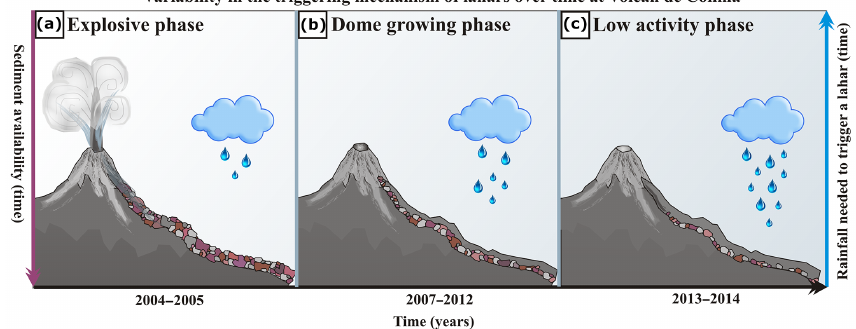
Figure 8. Conceptual model of the variability in the conditions needed to trigger a lahar over time at Volcán de Colima. (a) After the main explosive phase during 2004–2005, the slopes of the volcano were filled with material, and the rate of rainfall needed to trigger a lahar was minor. (b) During the dome growing phase (from 2007 to 2012), the amount of material decreased, while the amount of rainfall needed to trigger lahars was increasing over time. (c) Finally, during the phase of the lowest eruptive activity (from 2012 to 2015), the rate of material available to form lahars was diminishing, while a major quantity of rainfall was needed to trigger the